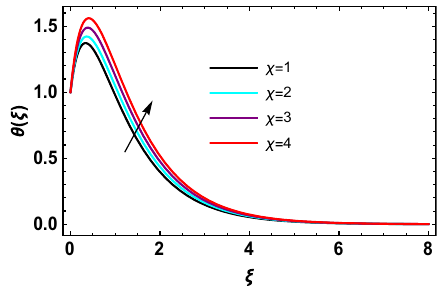
Figure 11. Impact of χ on θ(ξ) .